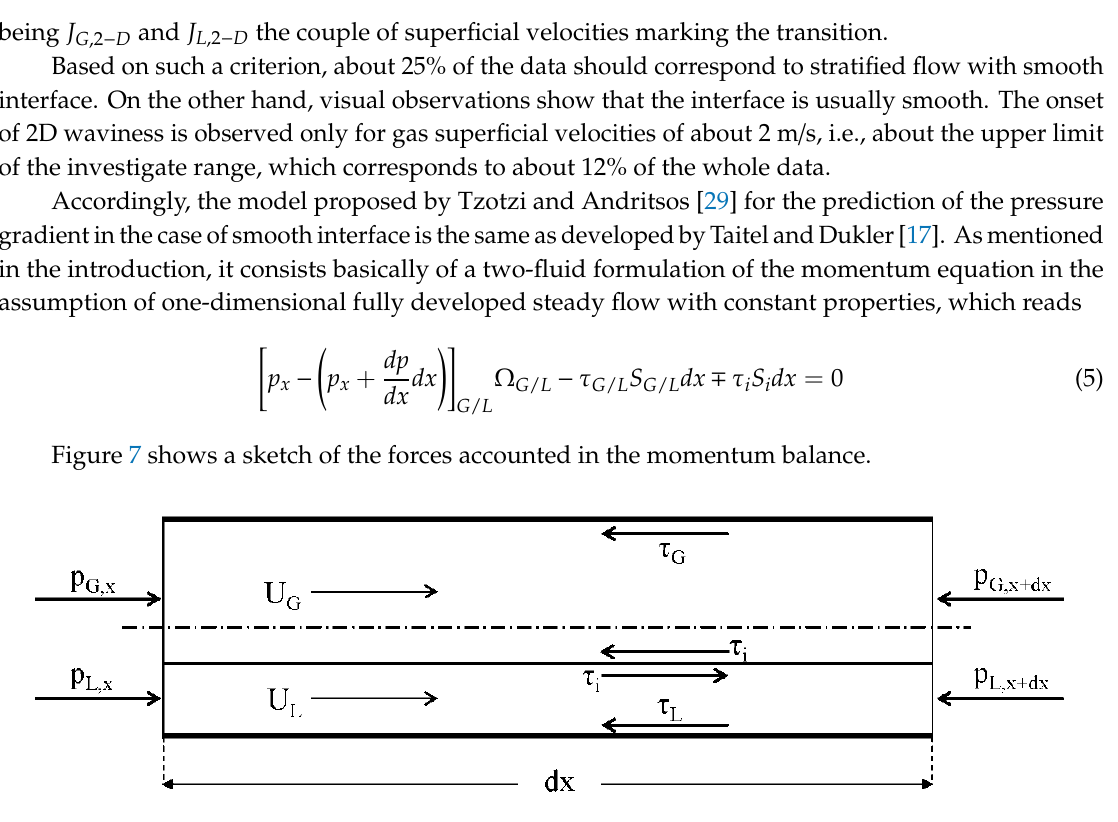
Figure 7. Two-fluid model momentum balance on a pipe element of length dx.